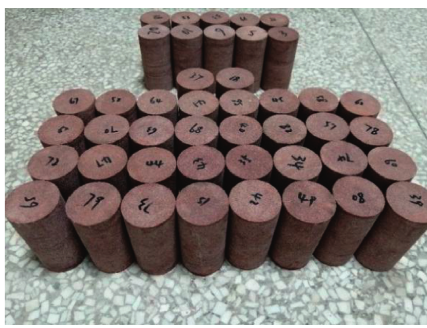
Figure 2: Sandstone